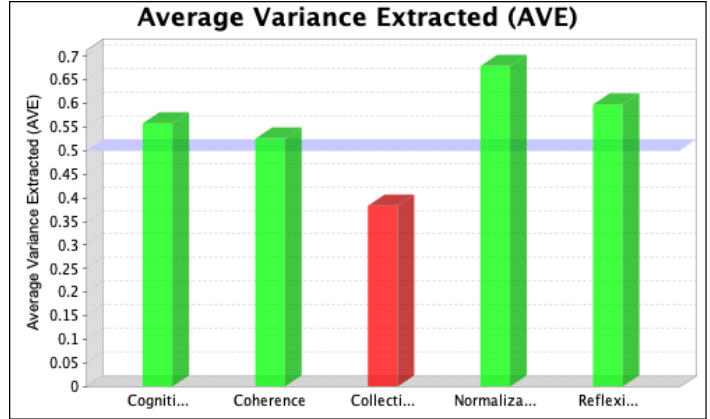
Figure 5. Values of average variance extracted in the first iteration.